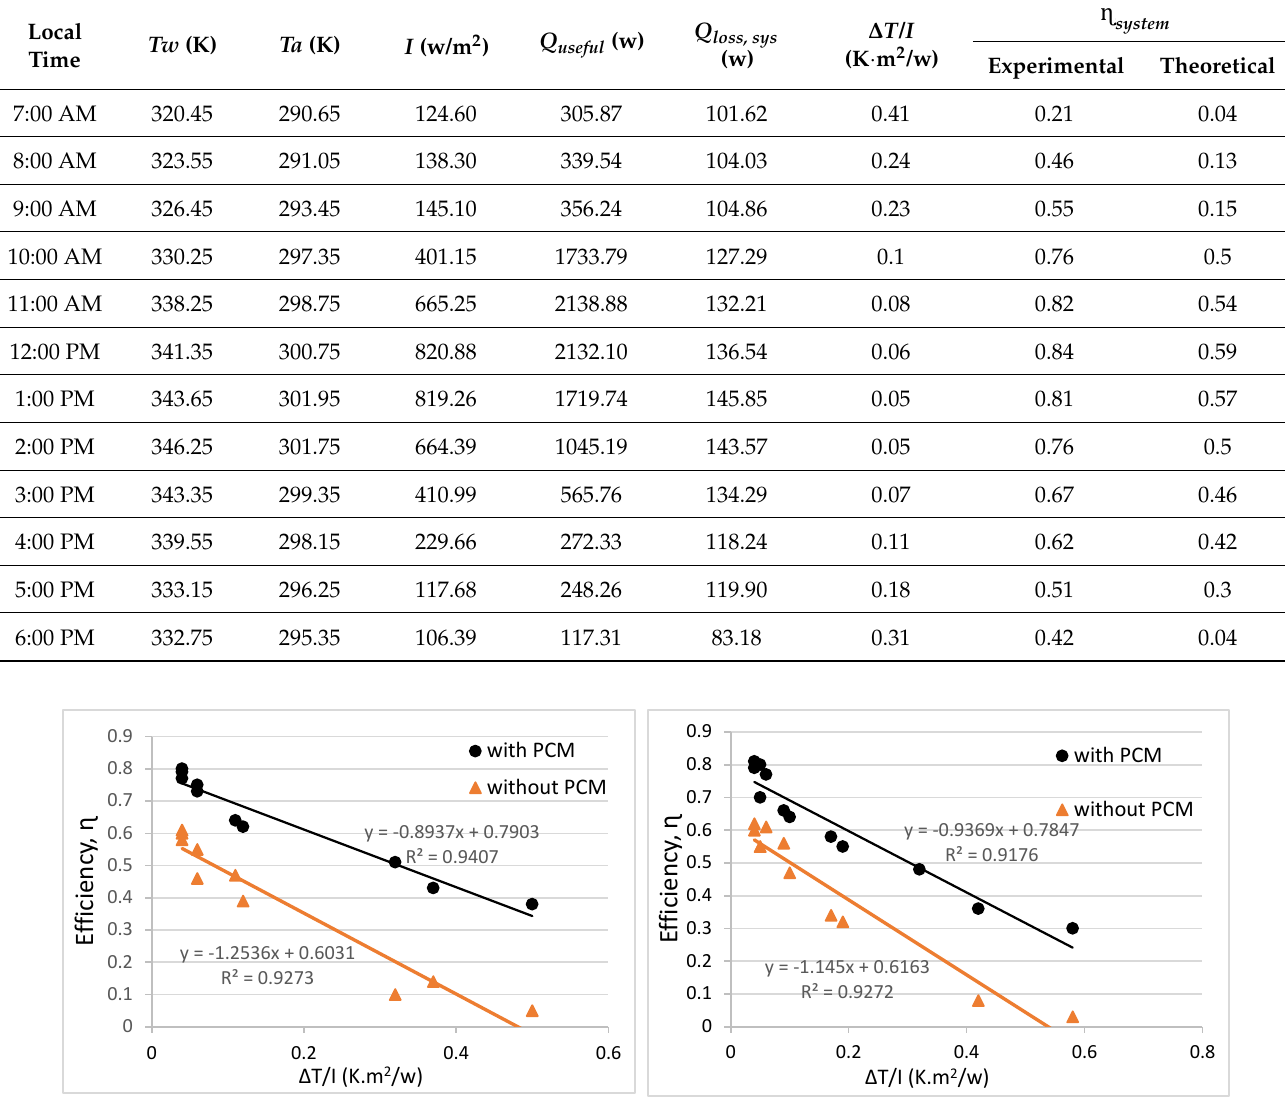
Table 5. Experimental and calculated results for June 2022 with paraffin.